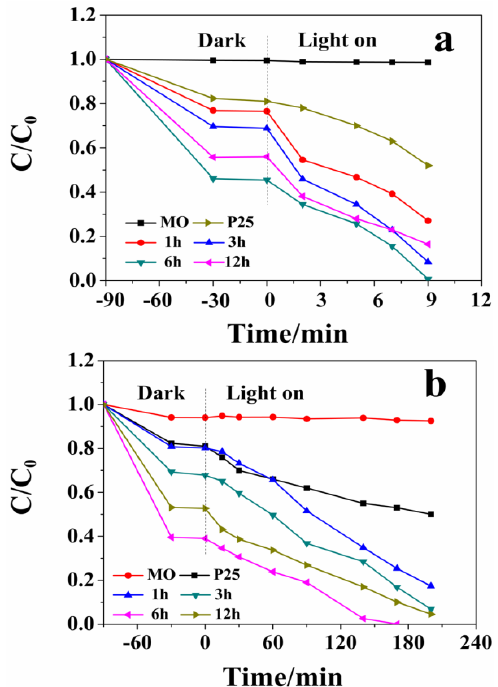
Figure 7. Photocatalytic properties of the products prepared under different solvothermal reaction times: ( a ) UV-light irradiation; ( b ) visible-light irradiation.